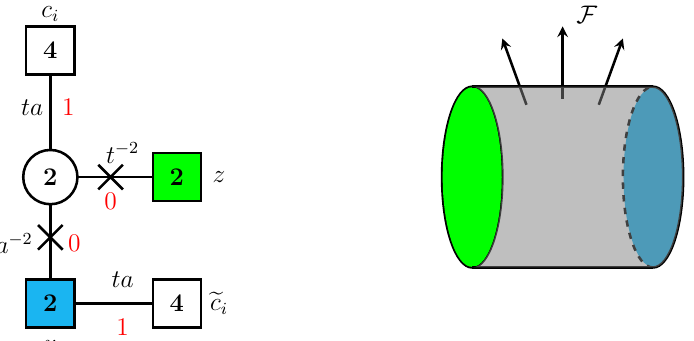
Figure 8: Quiver of the A 1